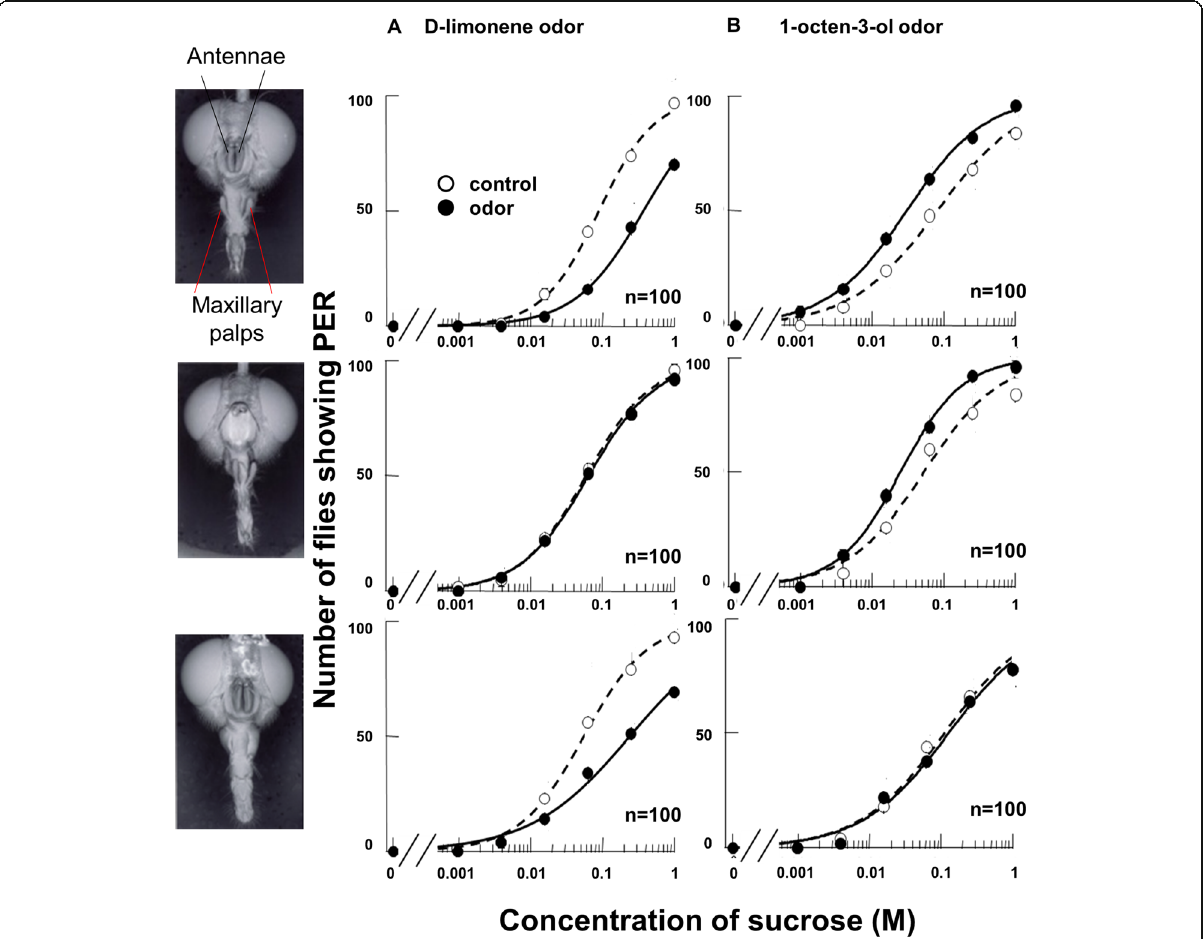
Fig. 5 Effect of D -limonene or 1-octen-3-ol odor on the PER in olfactory organ-ablated flies. Left panels show three different fly preparations having intact maxillary palps (MP) and antennae (AN) (top), intact maxillary palps but no antennae (middle), and intact antennae but no maxillary palps (bottom). a Sucrose concentration – PER curves in the absence (open circles) and presence (closed circles) of D -limonene odor. b Sucrose concentration – PER curves in the absence (open circles) and presence (closed circles) of 1-octen-3-ol odor. The number of flies exhibiting a PER is plotted against sucrose concentration; the curves of best fit were constructed using a curve-fitting program, Igor (HULINKS Ltd.). There was a significant difference between the PER thresholds in the two curves (Wilcoxon signed-rank test, p < 0.05; n =